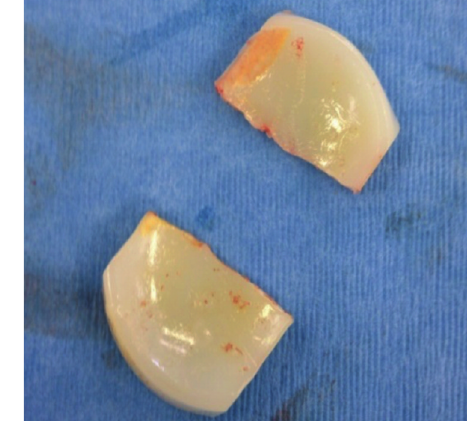
(a) AP and (b) Lateral radiographs with arrows showing Fig. 1: dislocated meniscal bearing insert.